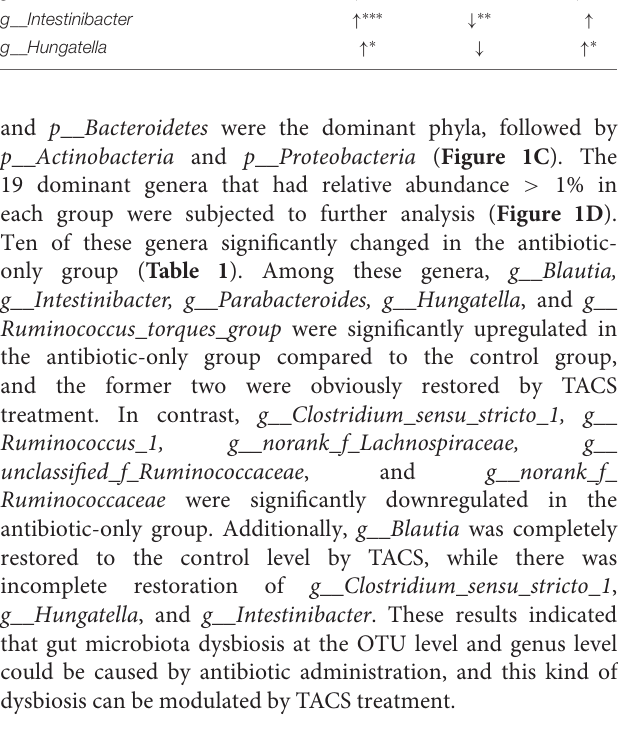
Supplementary Table 3 . Based on the accurate mass